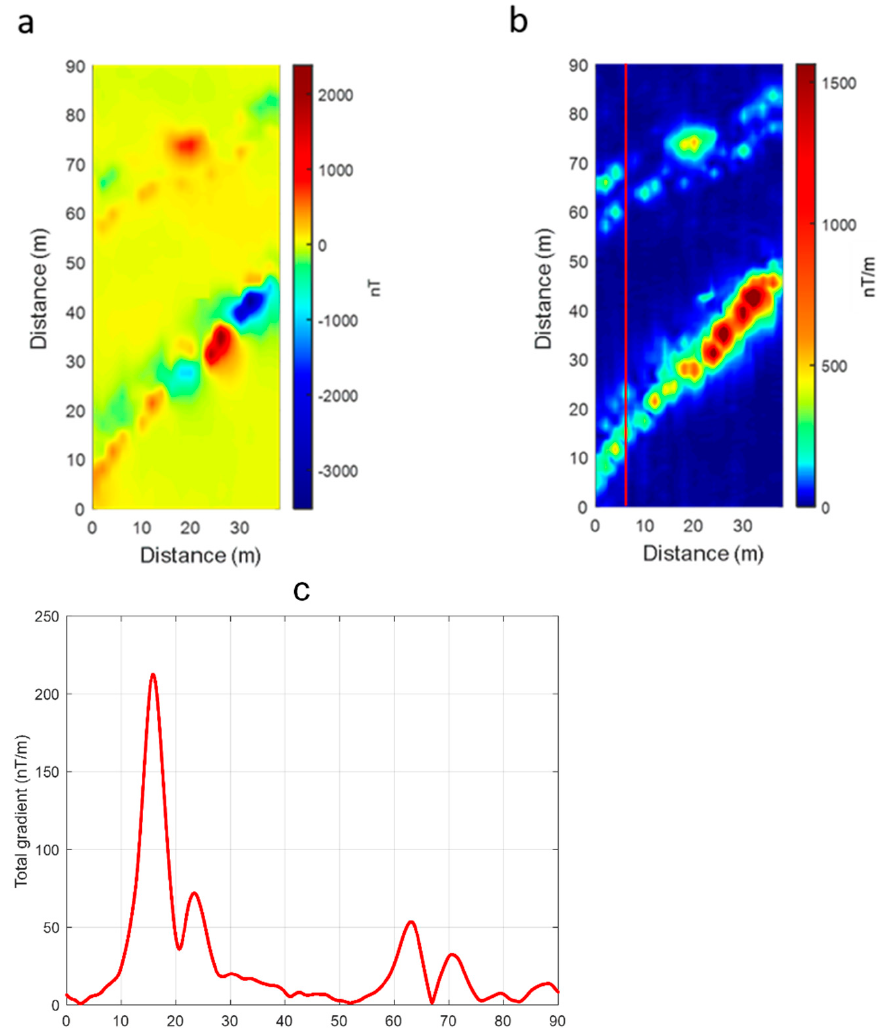
Figure 11. Ground survey dataset. ( a ) Total field anomaly map; ( b ) total gradient map; ( c ) total gradient of the profile data at x = 6 m (red line in Figure 11b). The secondary total gradient peak (at x = 25 m in this data profile) is sometimes visible on other profiles and could be related to another linear source.